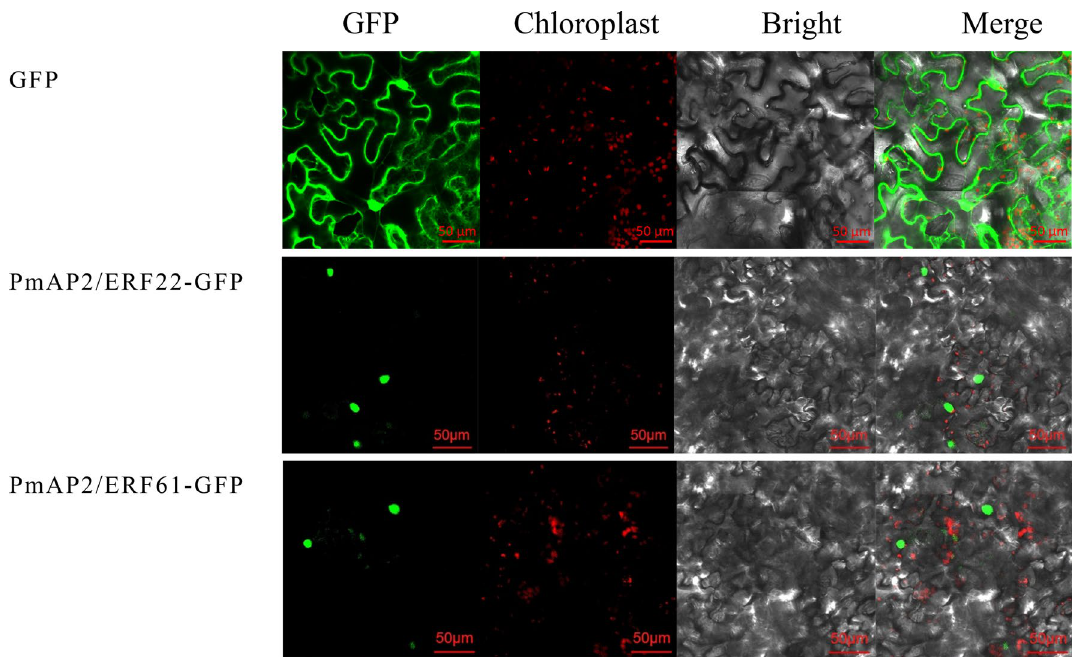
Figure 4. Results of subcellular localization assays of PmAP2/ERF22 and PmAP2/ERF61 in N. benthamiana